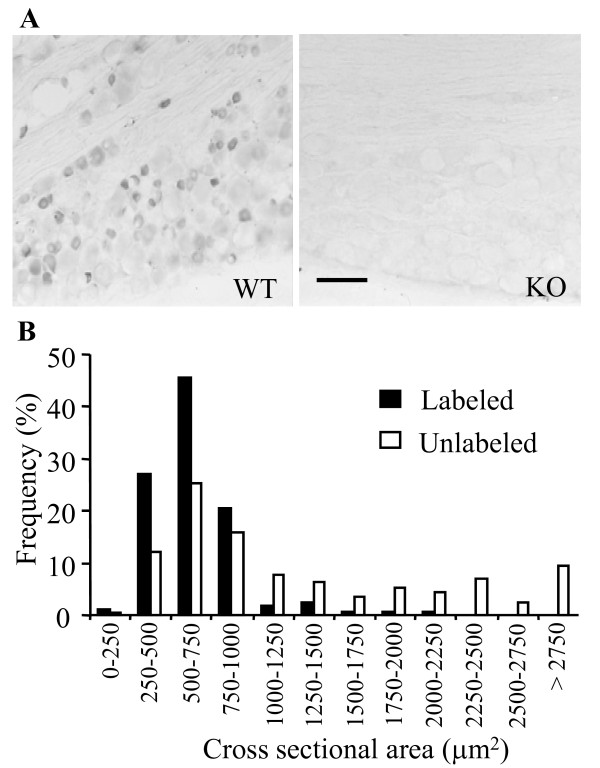
Localization and distribution of PICK1 immunoreactivity in the dorsal root ganglion (DRG). A, Distribution of PICK1 immunoreactivity in the DRG cells of wild-type (WT; left) and PICK1 knockout (KO, right) mice. No immunoreactivity for PICK1 was observed in the DRG of PICK1 KO mice. Scale bar: 200 μm. B, Histogram showing the frequency of PICK1-positive and -negative somata in the DRG of WT mice by cross-sectional area.